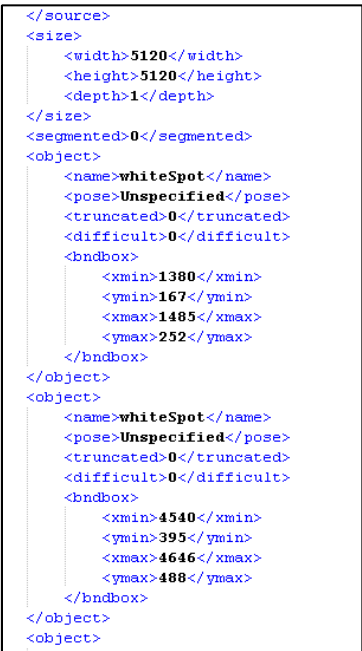
Figure 2. An example of a companion XML file for plenoptic images.